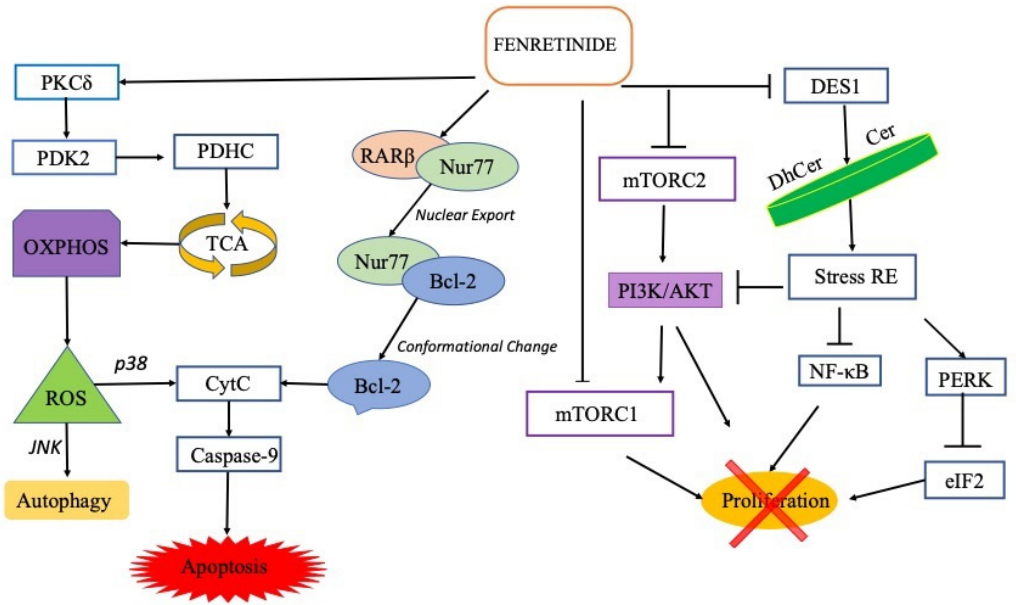
Figure 1. Schematic diagram of fenretinide activity in cancer. Pointed arrows represent pathway activation, and blunt arrows represent pathway inhibition. Fenretinide activates PKC δ in the mi- tochondrial signalosome with consequent activation of PDK2, PDHC, TCA and increased ROS production. High increase of ROS activates the p 38 apoptotic pathway with CytC release, caspase- 9 activation and induction of apoptosis. Moderate increase of ROS activates the JNK autophagy pathway.Fenretinide induces translocation of RAR β -Nur77 dimer from the nucleus to the cytoplasm where Nur77 binds Bcl-2 allowing their conformational change towards pro-apoptotic structures. Fenretinide inhibition of DES1 increases DhCer/Cer ratio and triggers endoplasmic reticulum stress with blocking of the PI3K/AKT/mTOR and NF-KB signaling pathways, as well as with blocking of eIF2 phosphorylation due to PERK. Moreover, fenretinide inhibits mTORC2 and mTORC1 by structural affinity with mTOR-ATP binding